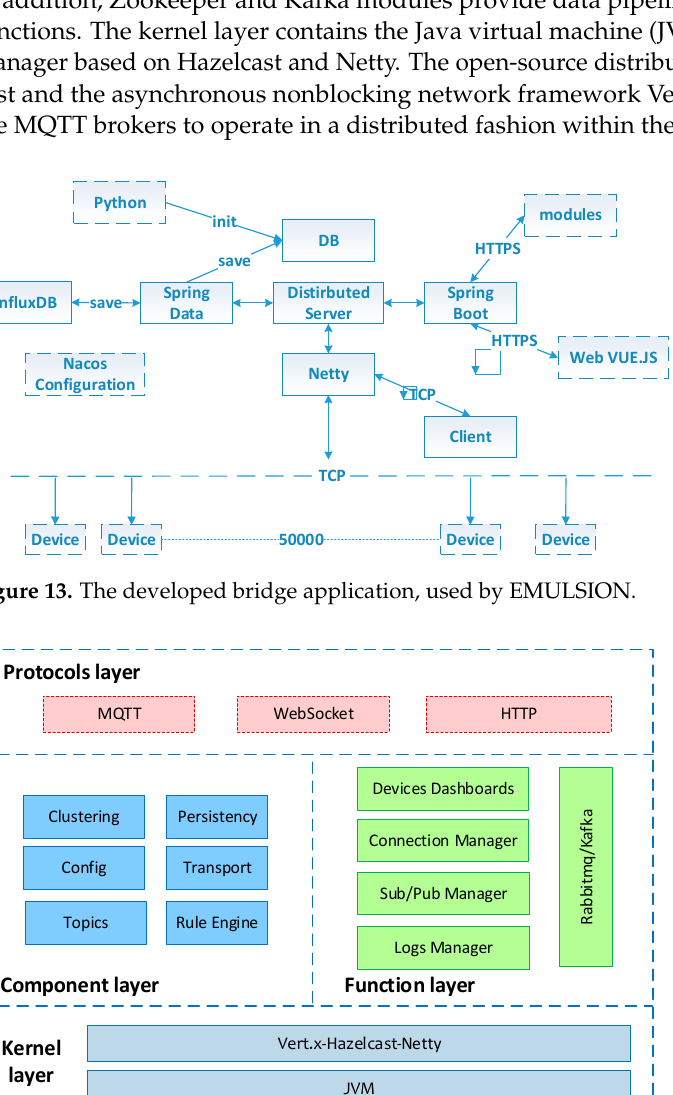
Figure 13. The developed bridge application, used by EMULSION.